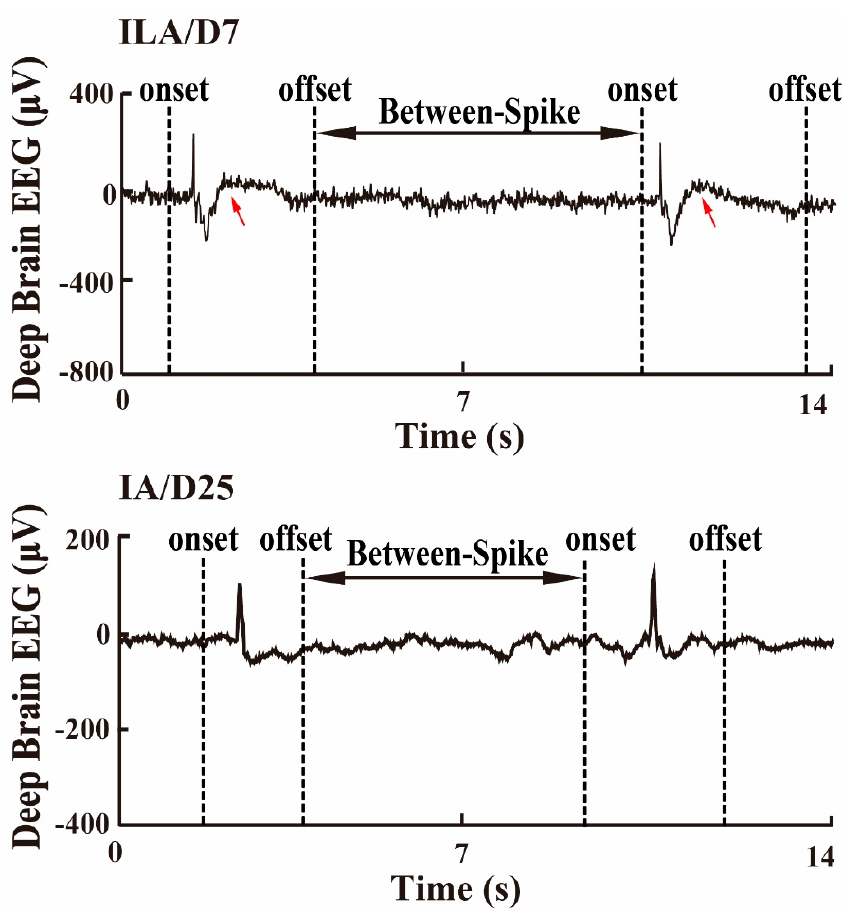
Figure 2. Between-spike period at D7 and D25 on a segment of deep-brain EEG. Red arrow indicates the character of ILA.